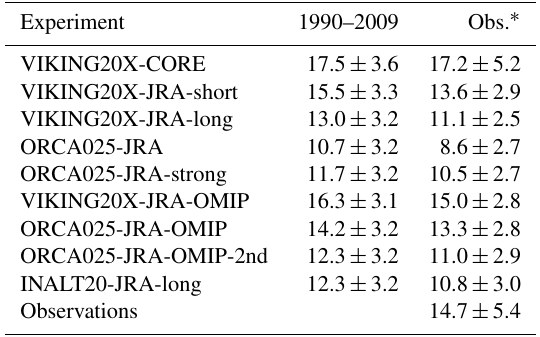
Table 8. Mean and standard deviation based on monthly data of the AMOC transport (in Sv) at 34.5 ◦ S for the period 1990–2009 and subsampled in the observational period (Obs.) (for VIKING20X- CORE only the overlapping year 2009 is